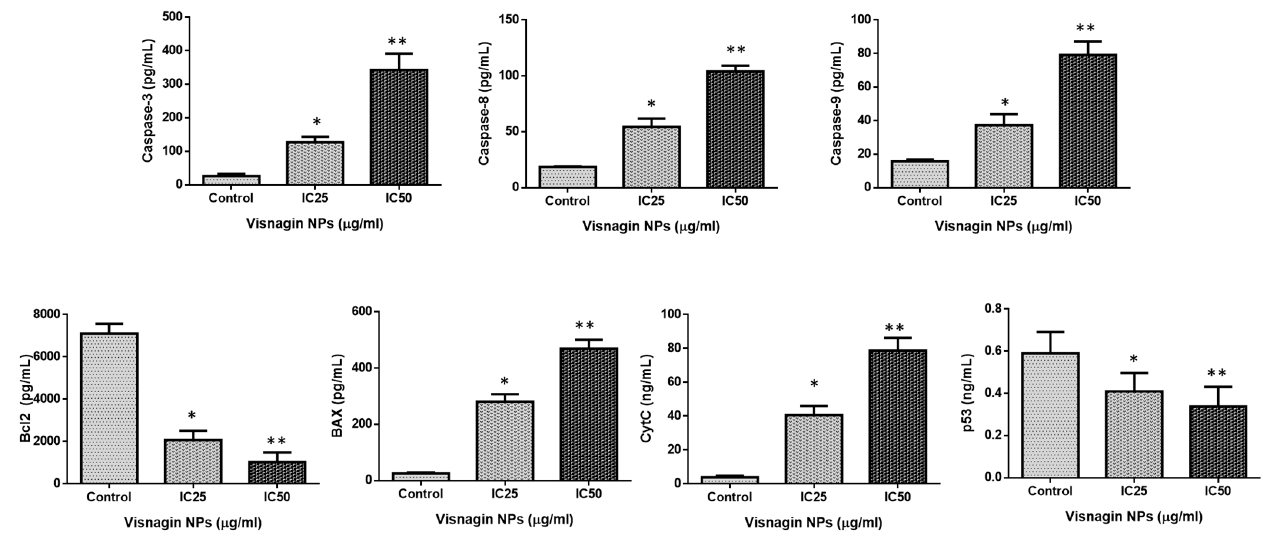
Figure 10. Albumin visnagin NPs inhibit cell proliferation in MDA-MB-468 cells (b) and promote apoptosis. Activities of caspase-3, 8, 9, Bax, Bcl-2, CytC, and P53 in both cells were determined using